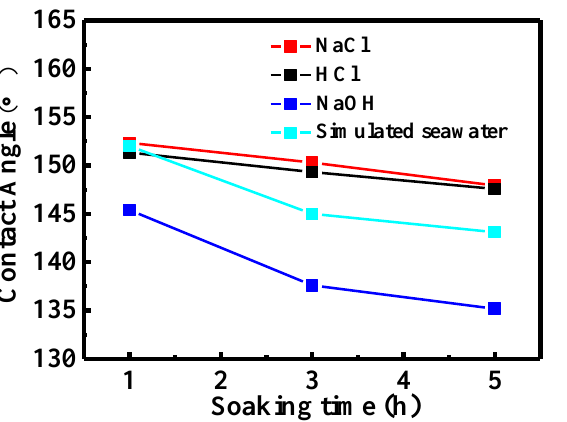
Figure 7. Contact angle of modified sponge treated with corresponding solution for different times.